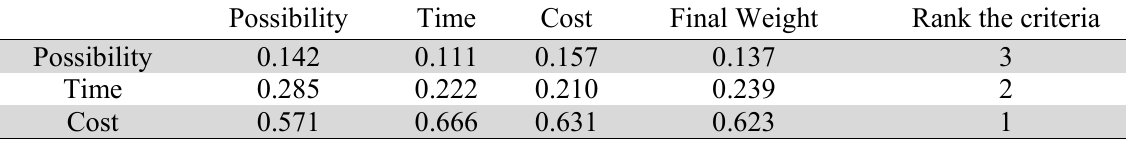
Rank the criteria Final Weight Cost